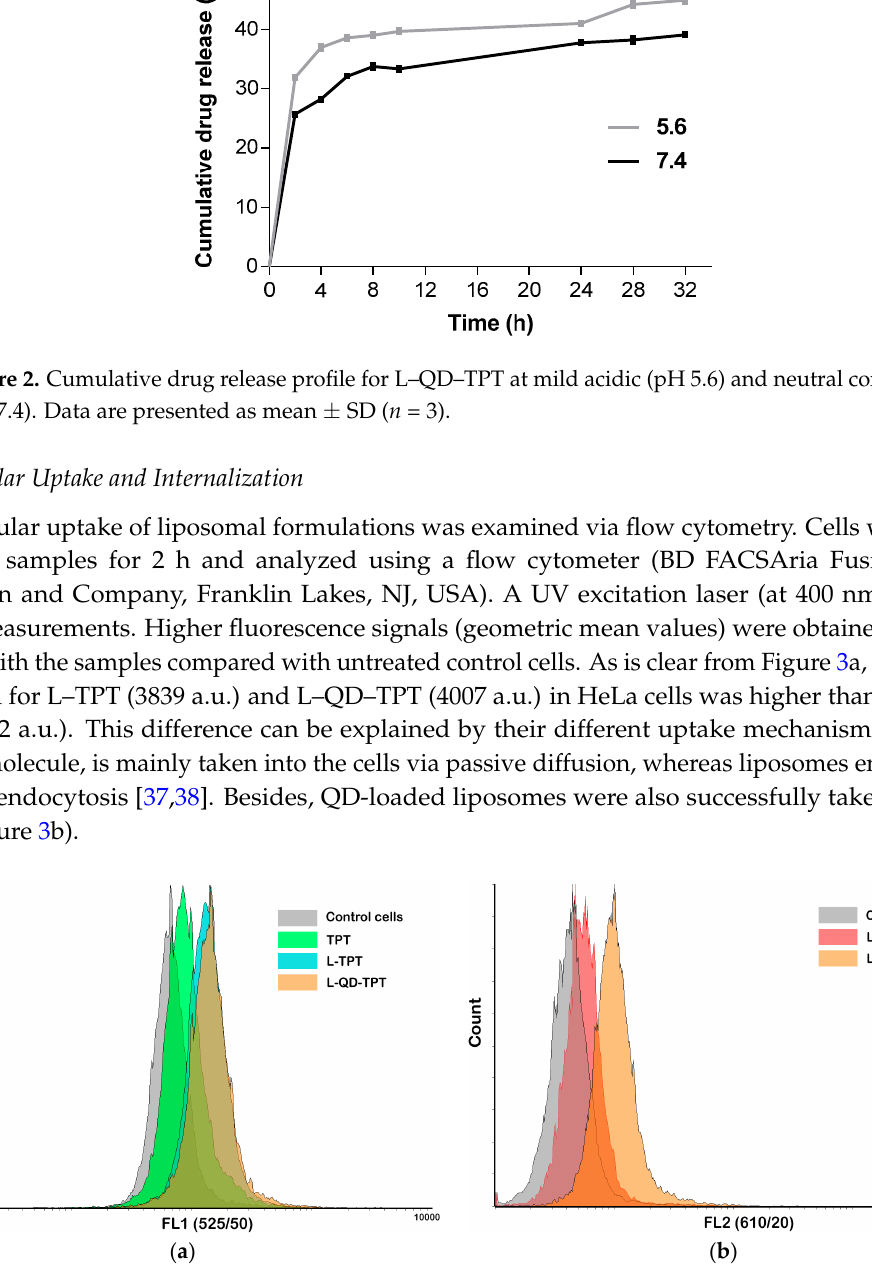
Figure 3. Cellular uptakes of the conjugates were determined in HeLa cells by flow cytometry. TPT, L–TPT, L–QD–TPT ( a ) (excitation at 400 nm, emission filter FL1 (525/50 nm)); L–QD and L–QD–TPT ( b ) (excitation at 400 nm, emission filter FL2 (610/20 nm)).